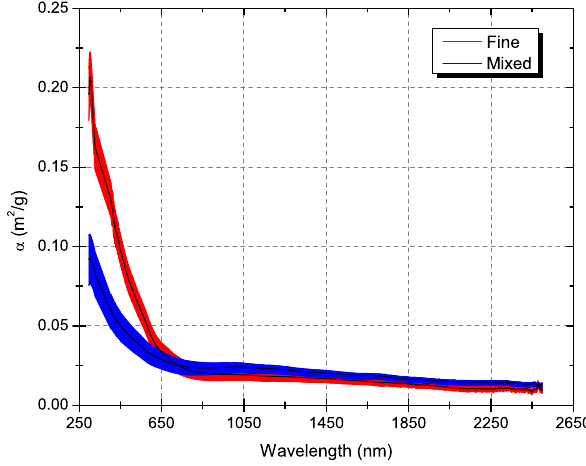
Figure 9. Imaginary part of the complex refractive index for mixed and fine particles using Mie theory with n =1.68 and density ρ = 2 . 16gcm − 3 . The error bars of the imaginary part of the complex refractive index were estimated by studying the sensitivity of the minimization method to the uncertainties of the real part of the refractive index, the mass absorption efficiency, the particles’ cross-section, volume, and density.